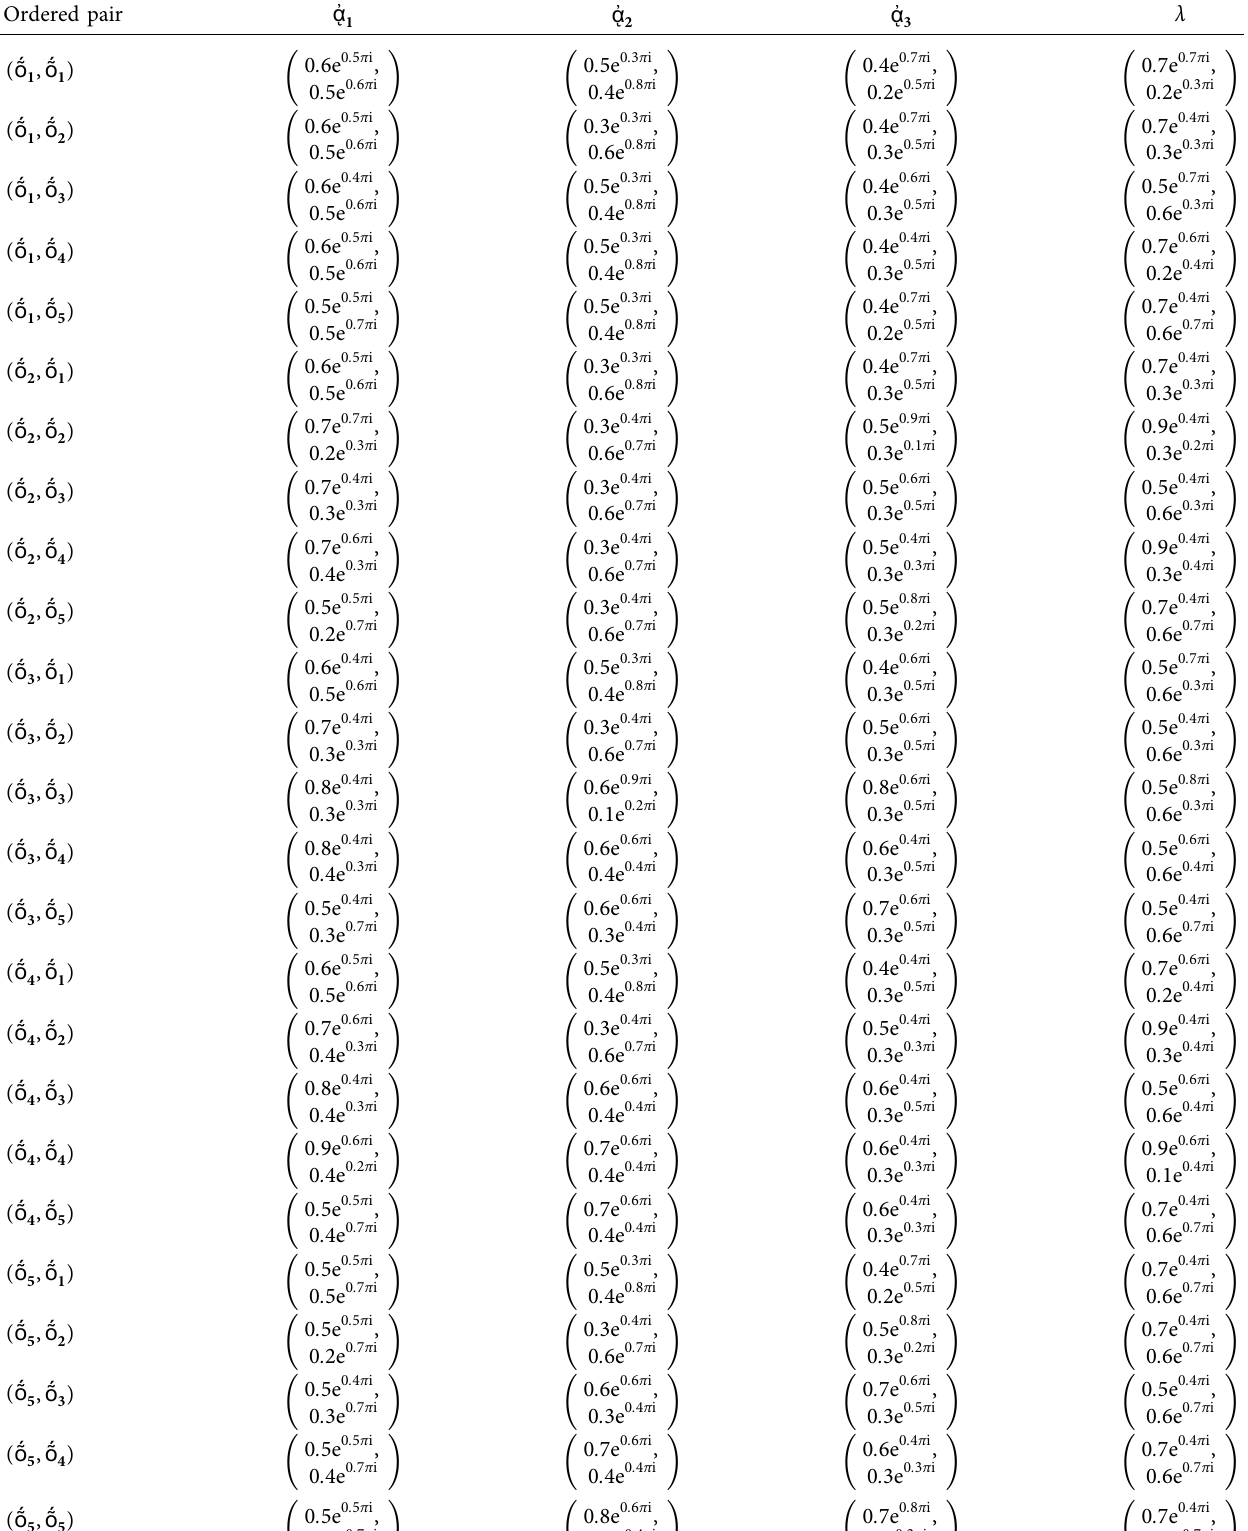
Table 2: Cartesian